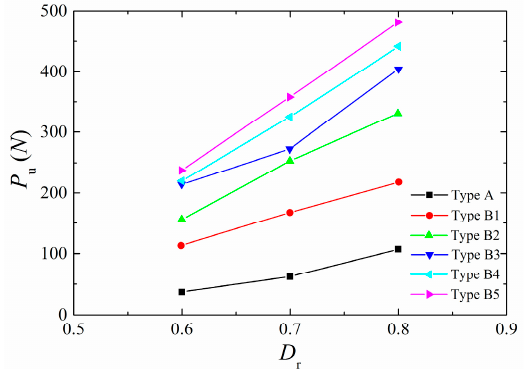
Figure 9. P – D r curves of the TAs under vertical pullout loading.